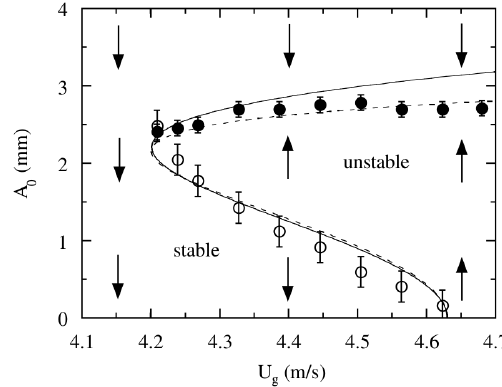
Figure 8. Reproduced from [16]. Nonlinear stability diagram in the space of the forcing amplitude A 0 against the gas velocity U g (instability drive). The open circles show the amplitude threshold for the subcritical instability. The filled circles show the saturation amplitude. The curves are fits of the experimental results by a reduced theoretical model. See the reference for